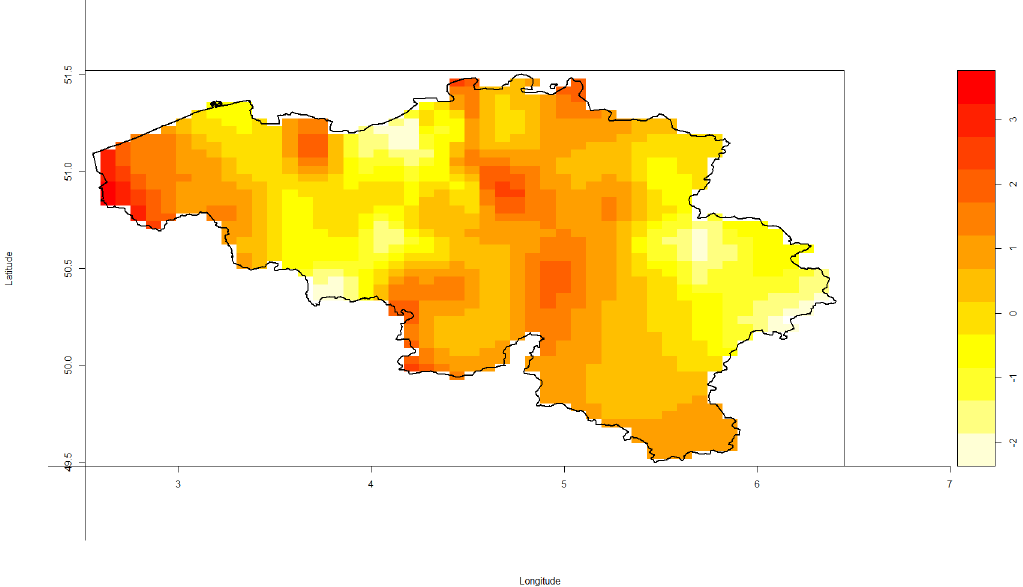
Fig 2. The heat plot represents the log of the ratio of the densities of spatially dependent and random sampling. Spatial heterogeneity was based on the relation between the location of the labs and the location of the generated cases. Yellow zones represent regions where cases are less likely detected by lab-surveillance (either NRC or sentinel surveillance) in the spatial heterogeneity scenario, as compared to random